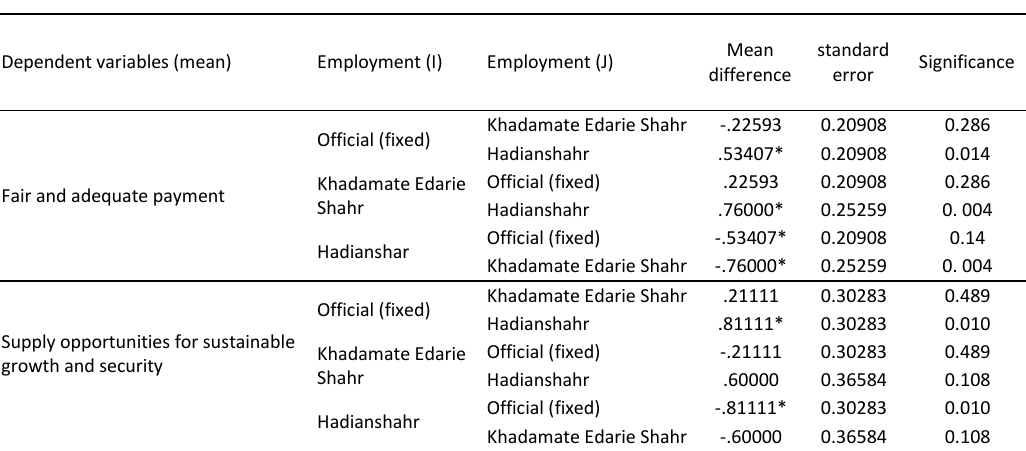
Table 4: Follow-up statistics of comparisons of means based on type of employment